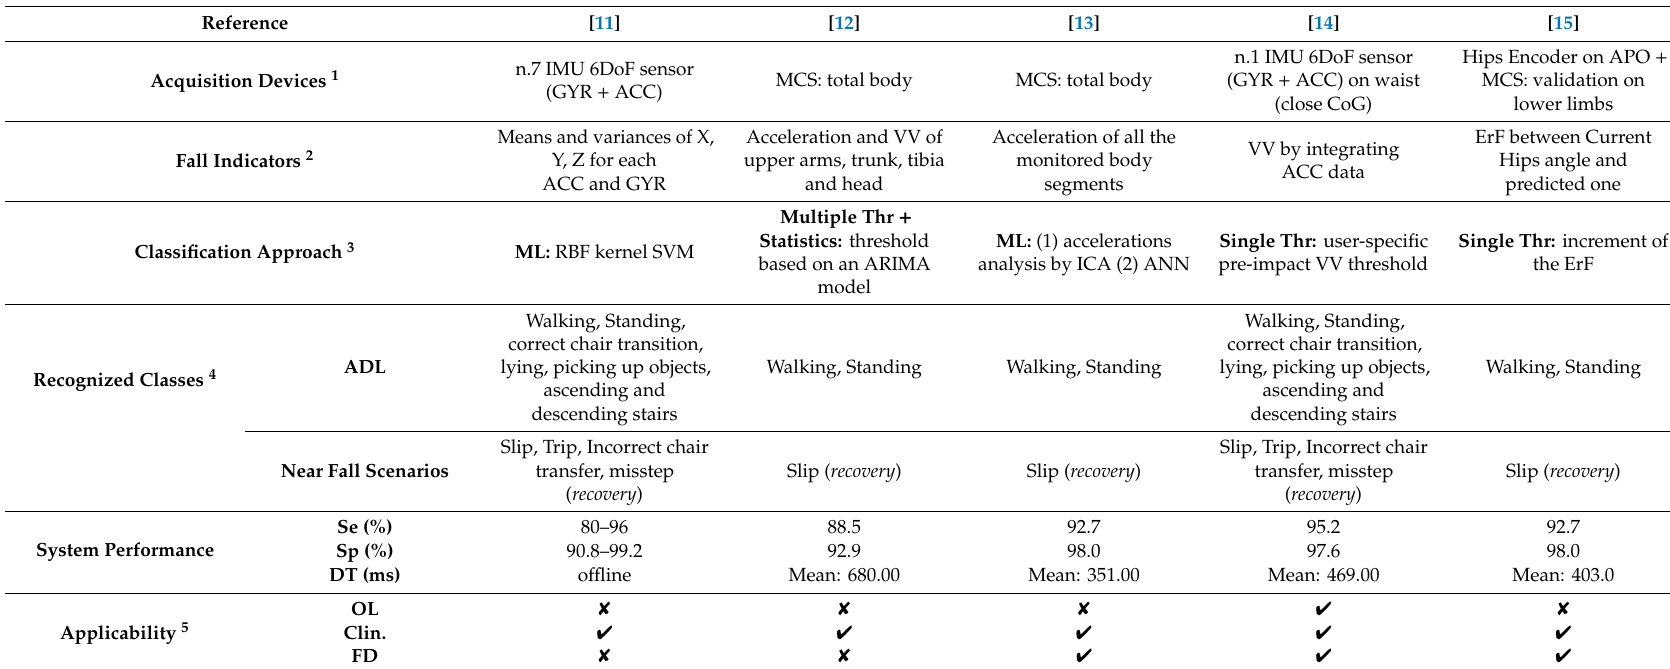
Table 1. State-of-the-art overview: features, performance (accuracy and e ffi ciency) and